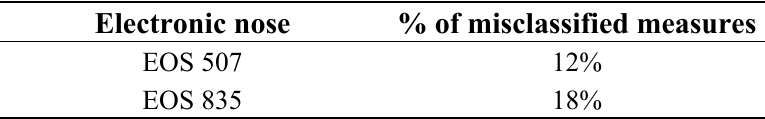
Table 4. % of misclassified measures obtained by cross validation of the training